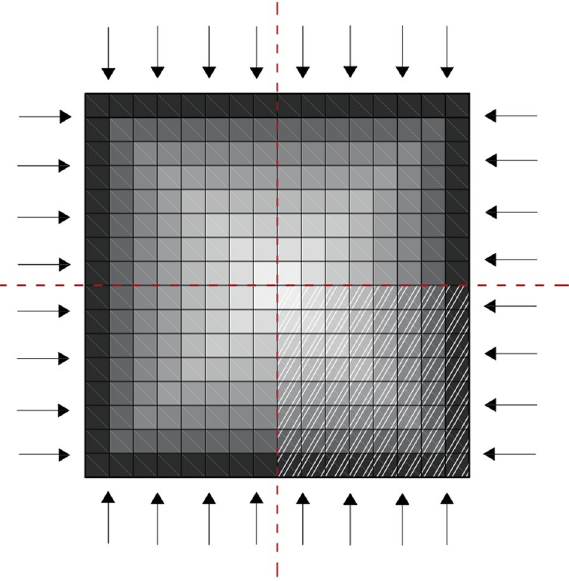
Figure 2. Example of 2D model of column’s square cross section, used for the thermal